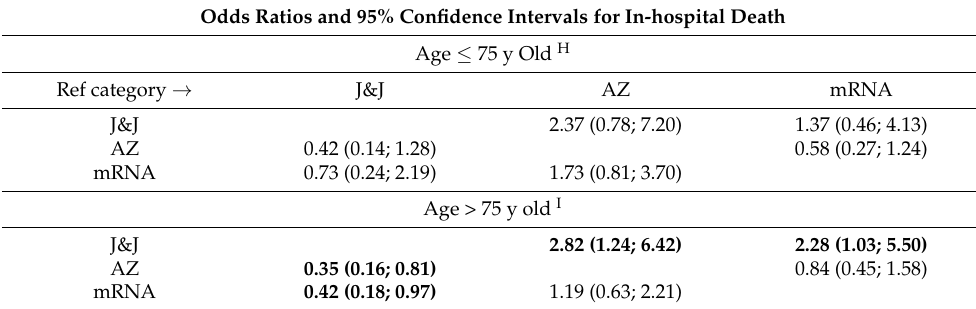
Table 5. Secondary results stratified on age for outcome in-hospital death. Odds Ratios and 95% Confidence Intervals for In-hospital